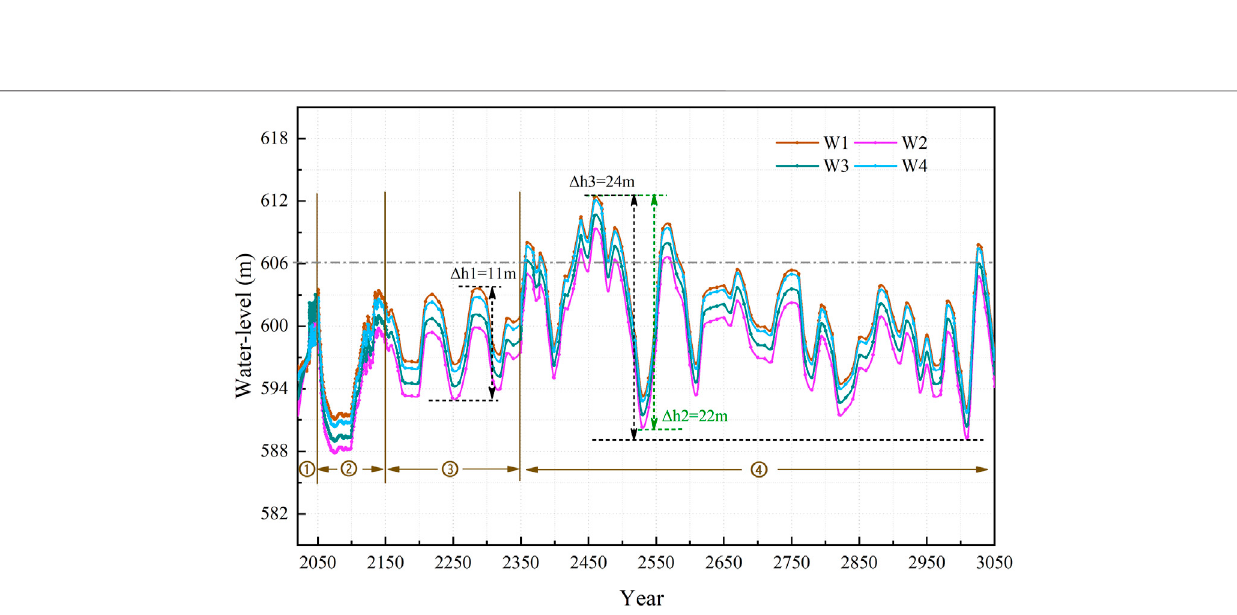
Frontiers in Environmental Science |